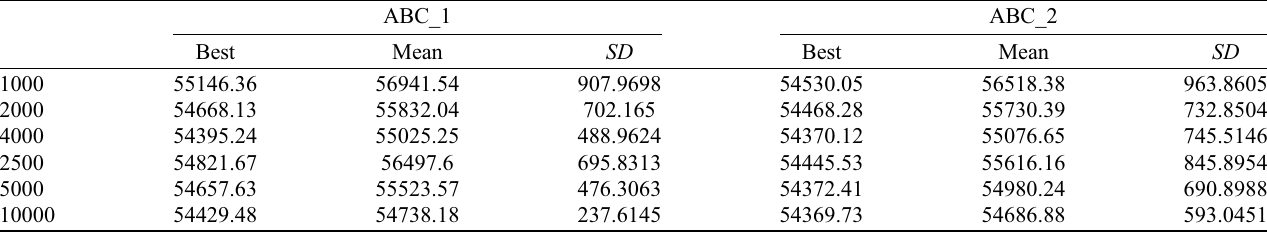
Table 3. Comparison of different variants of ABC algorithm for Example 2 (Orthogonally stiffened cylindrical shell) with different function evaluations for the best solutions obtained in 100 runs.